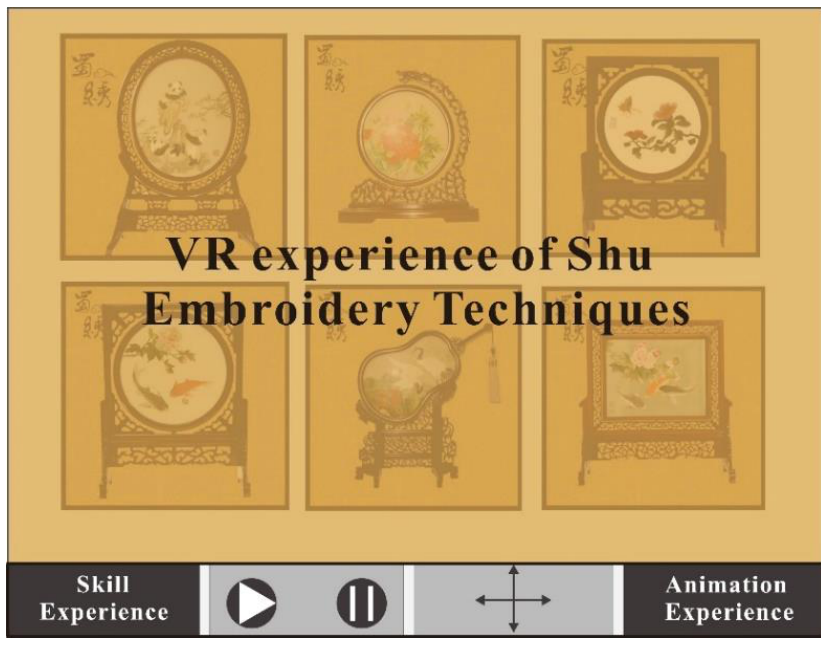
Figure 9. Interface